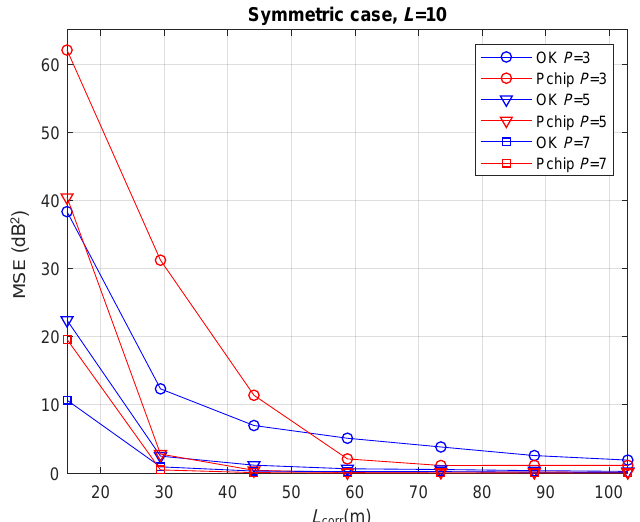
Figure 6. Minimum MSE of path-loss and shadowing estimation versus shadowing correlation distance in the symmetric case with L = 10 m.